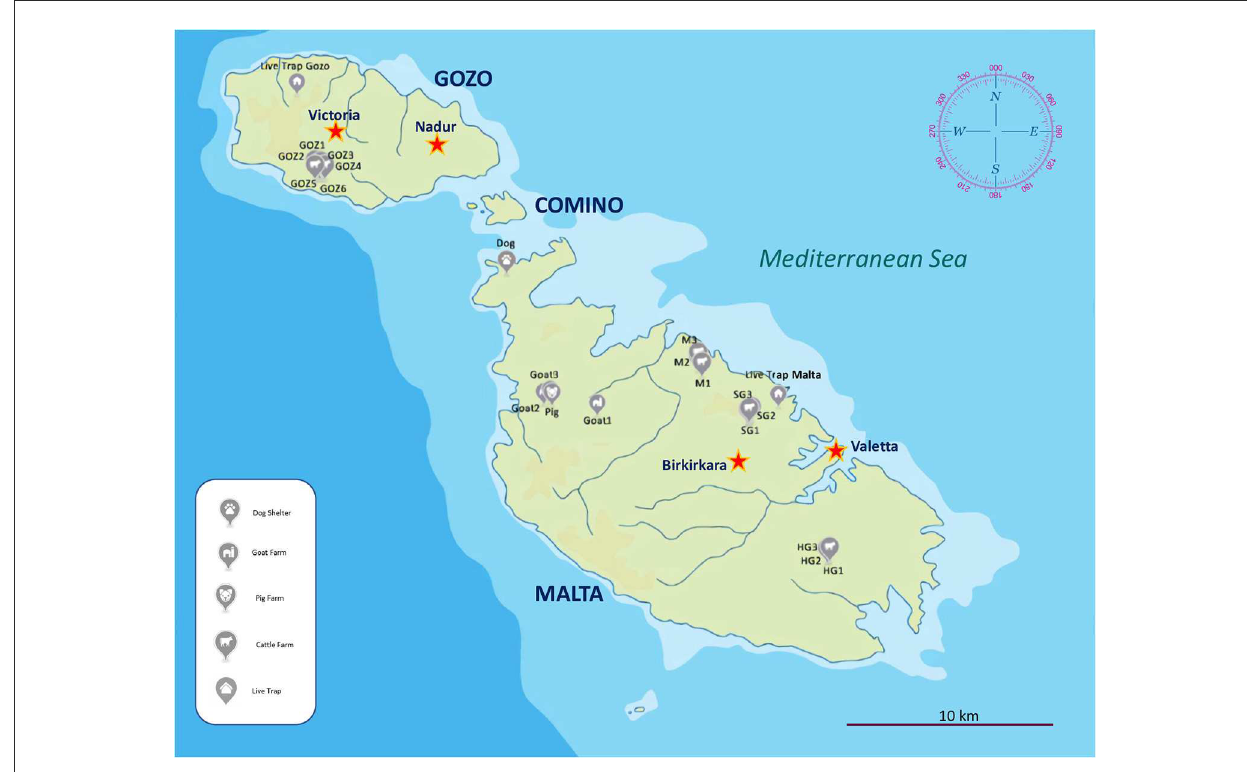
FIGURE1 Map of the Maltese Islands indicating sampling locations (registration numbers), with the silhouette of sampled animals.